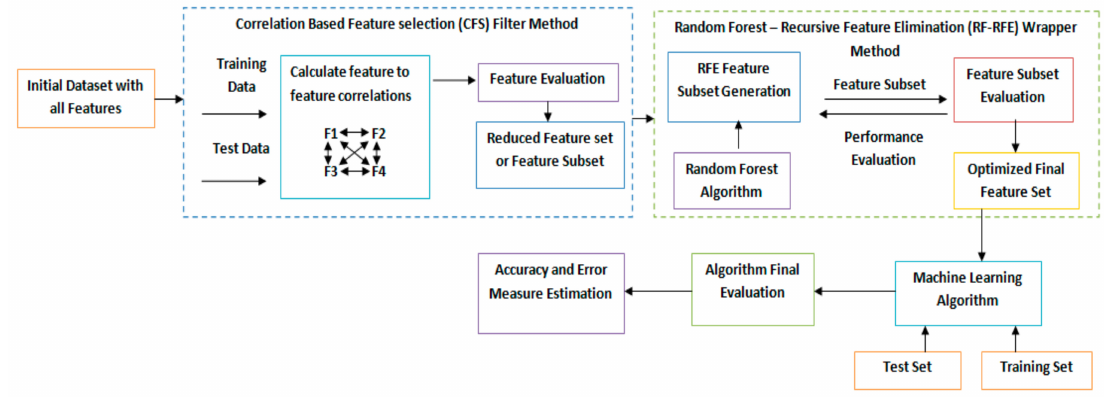
Figure 3. Architecture diagram of proposed hybrid CFS and RF-RFE feature selection